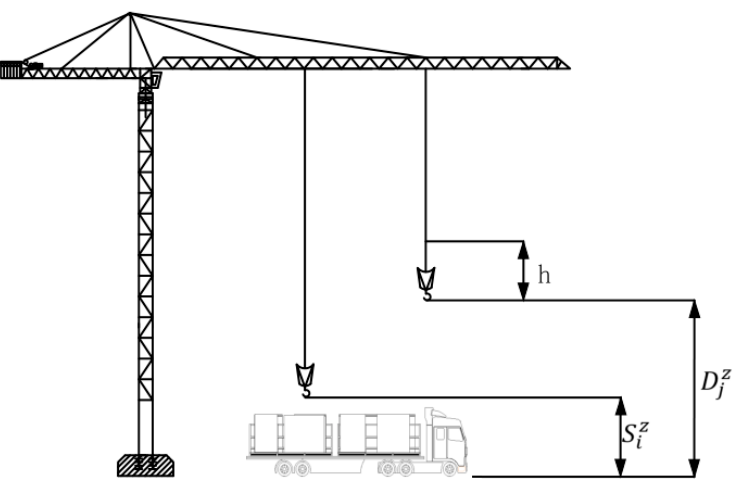
Figure 3. Vertical movement of the